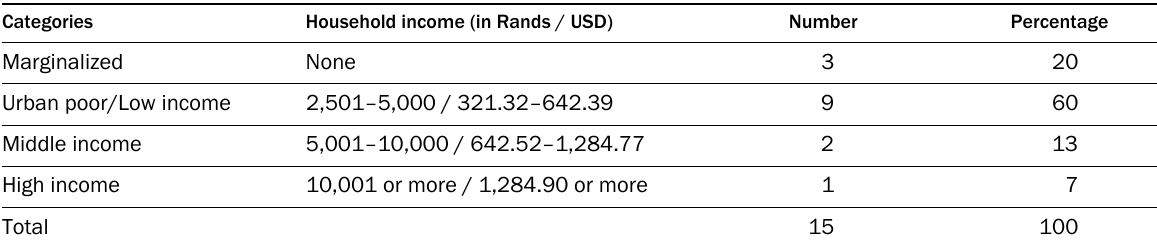
Table 2. Household Income of Urban Farmer Respondents in KwaMashu (n=15)